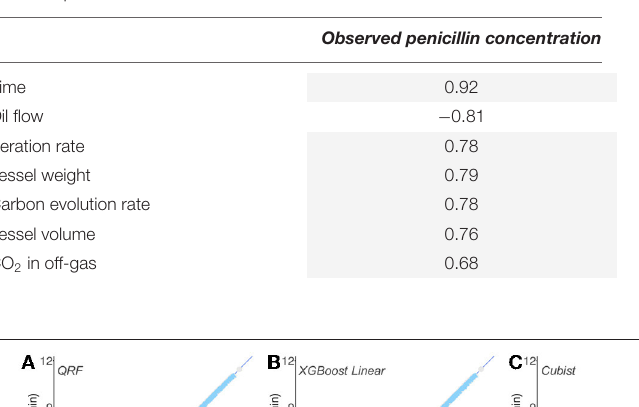
Frontiers in Artificial Intelligence |